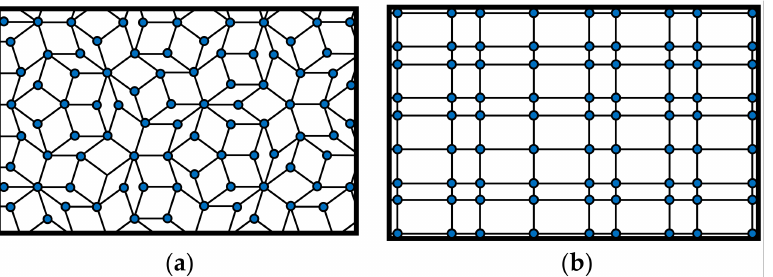
Figure 4. Some quasiperiodic/aperiodic 2D spatial lattices of the electromagnetic scatterers. ( a ) Penrose quasicrystal (aperiodic lattice); ( b ) 2D square Fibonacci sequence